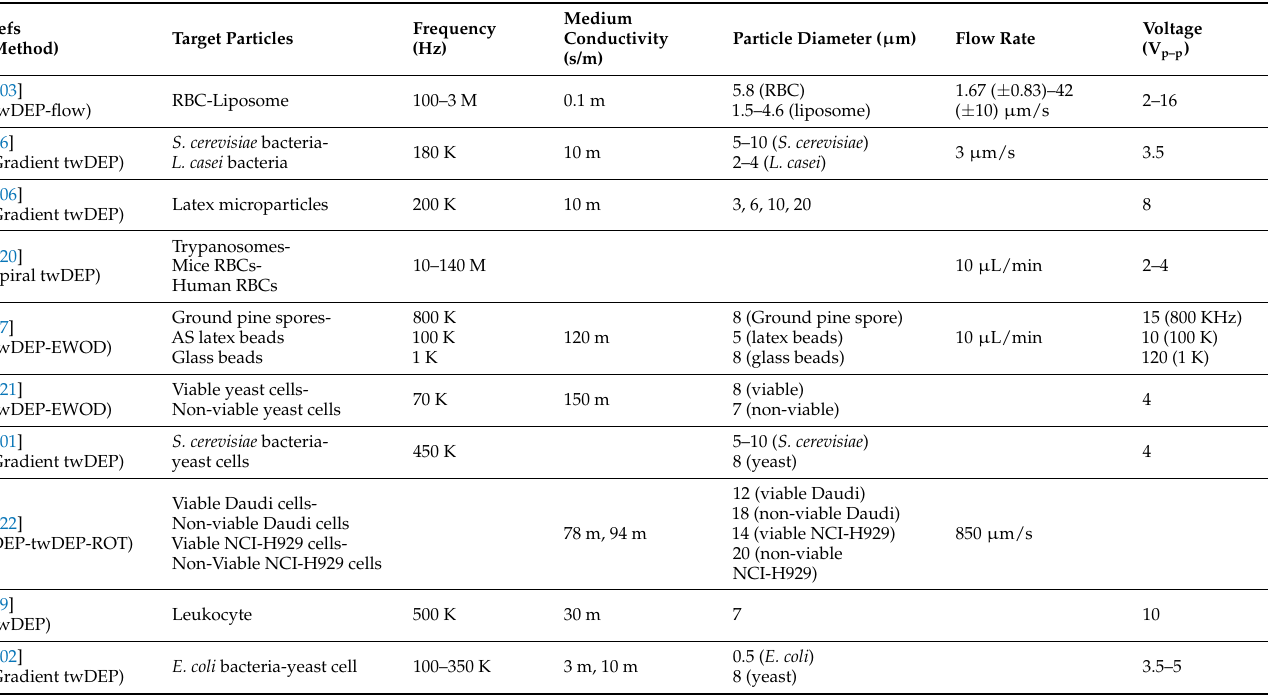
Table 3. TW-DEP methods’ reported parameters.